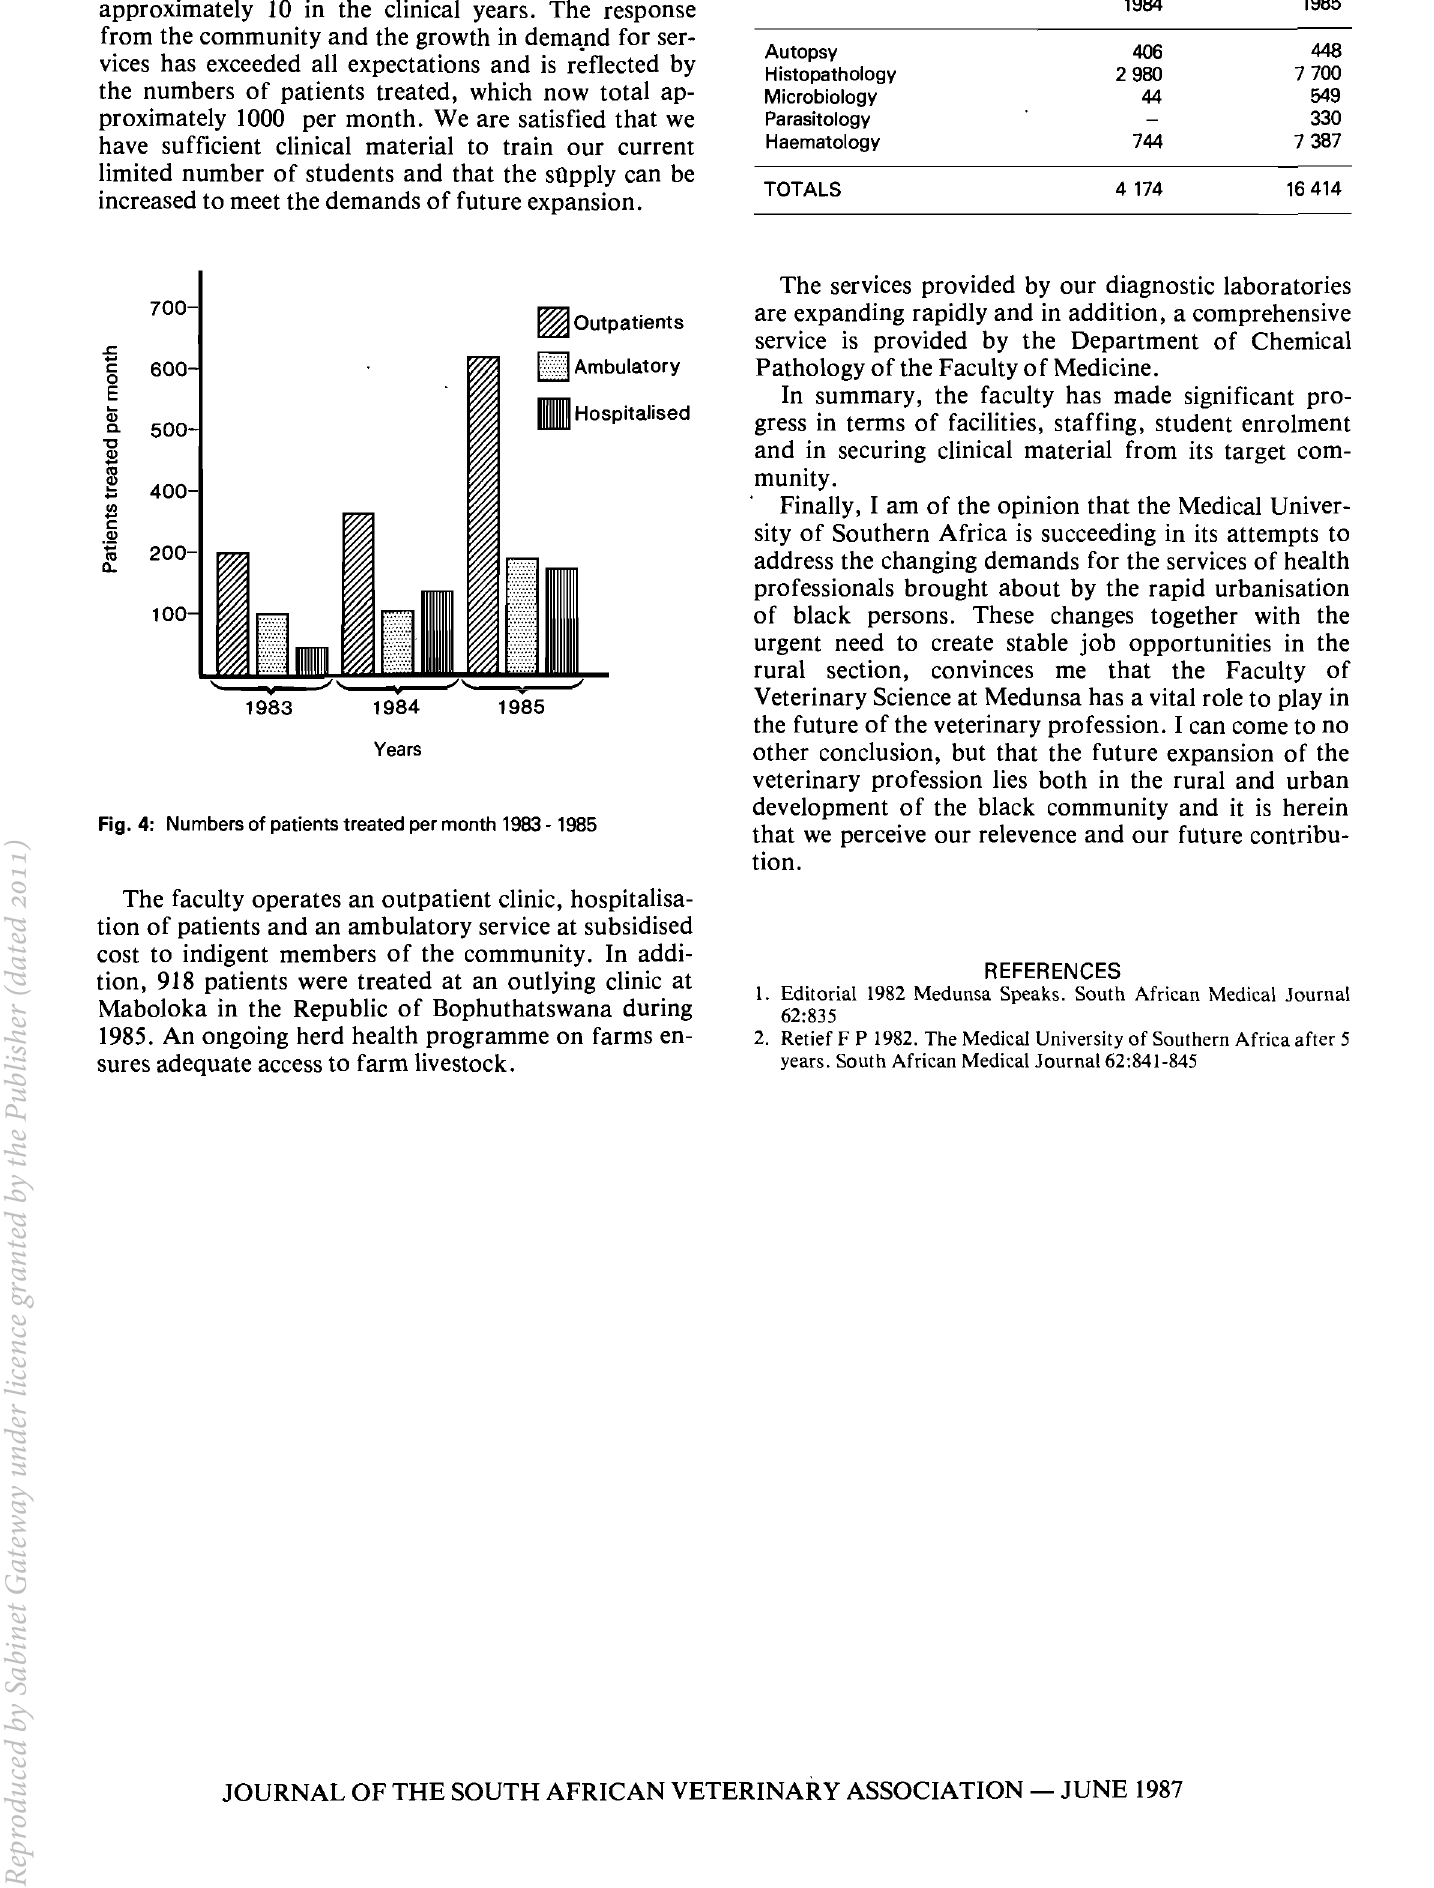
Table 1: Expansion of Diagnostic Services (Excluding Chemical